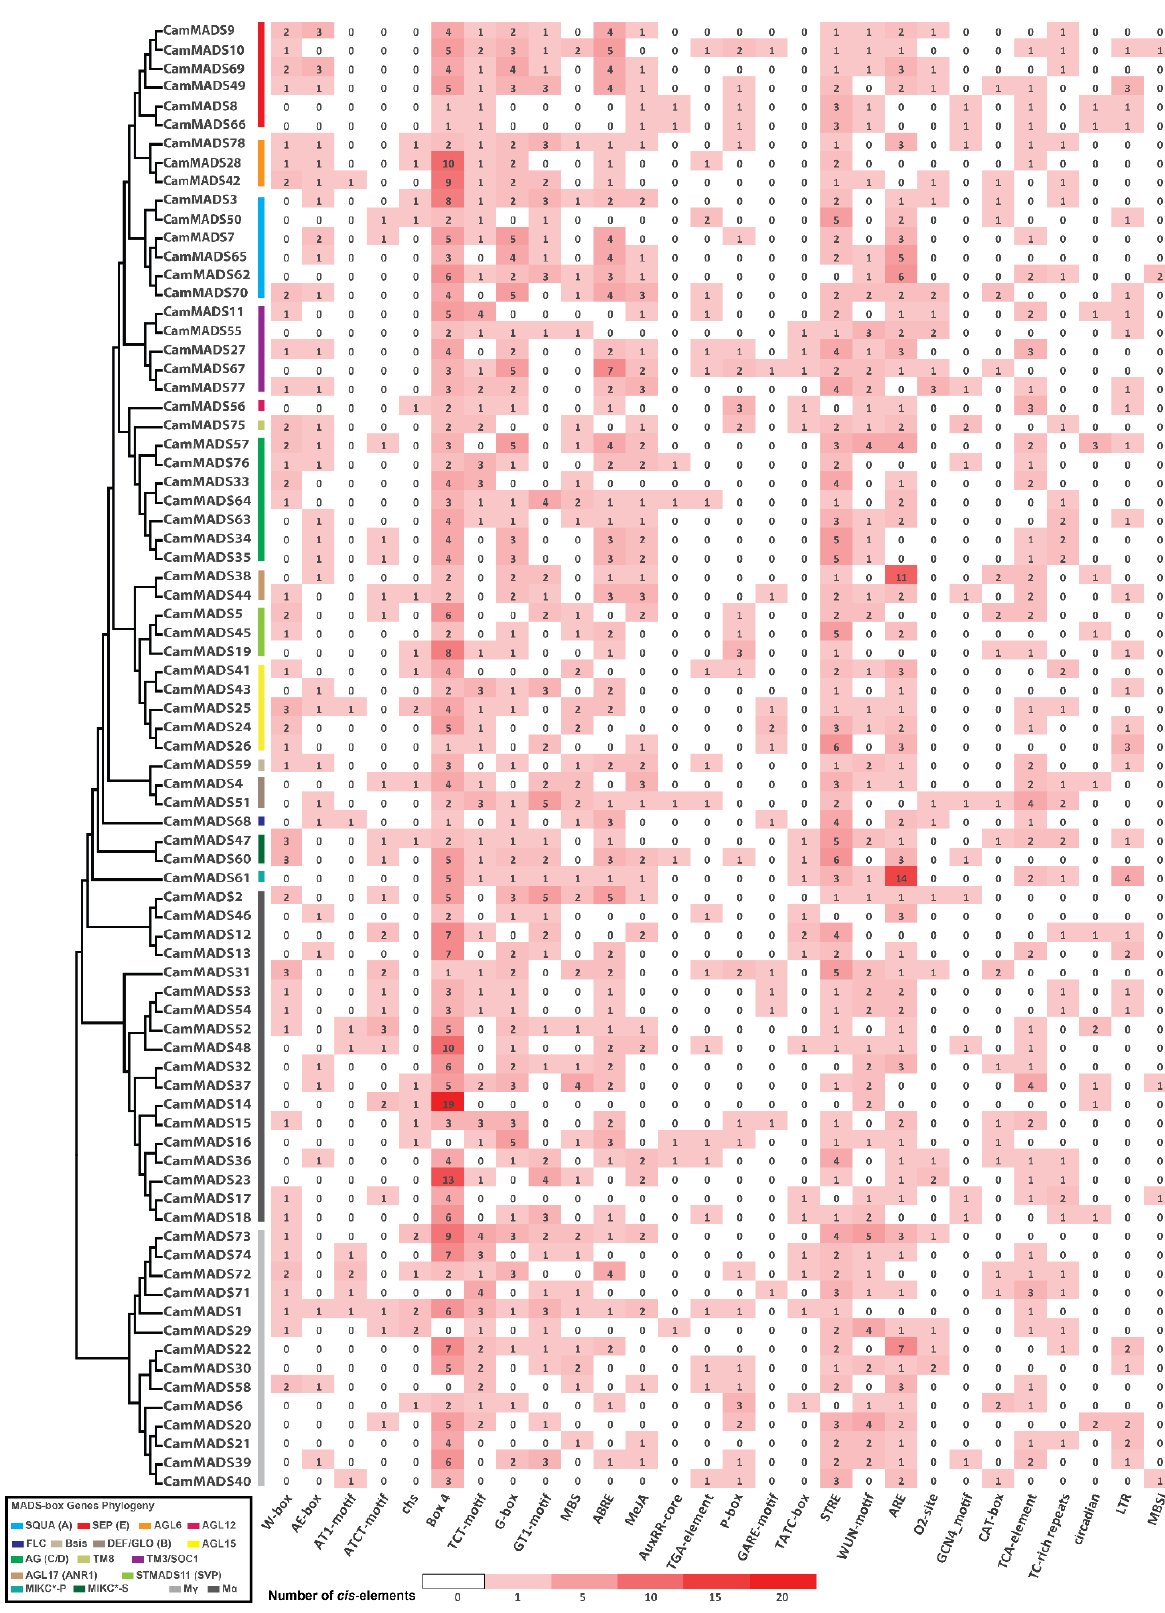
Figure 7. Analysis of Cis -acting elements of MADS-box gene family in C. americana: W-boxes, TC-reach repeats, AE-box, AT1-motif, chs, Box4, TCT-motif, G-box, GT1-motif, MBS, MYB binding site, ABRE, MeJA, AuxRR-core, TGA-element, P-box, GARE-motif, TATC-box, STRE, WUN-motif, ARE, O2-site, GCN4_motif, CAT-box, TCA-motif, Circadian, LTR, and